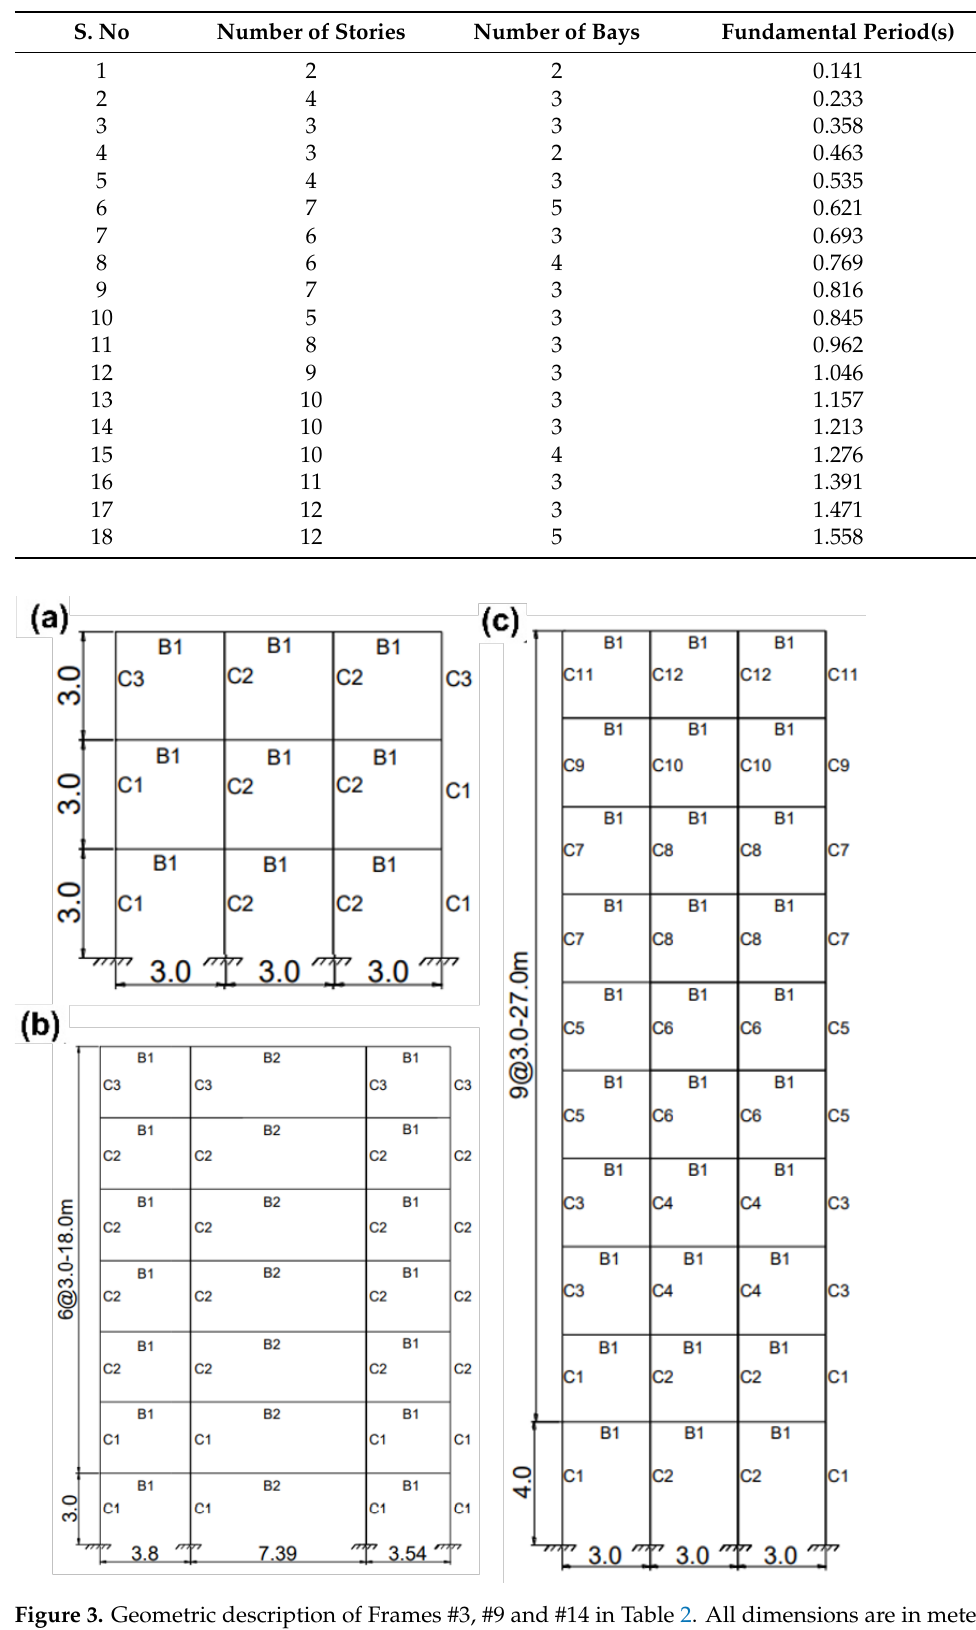
Table 2. Structural properties of selected frames.